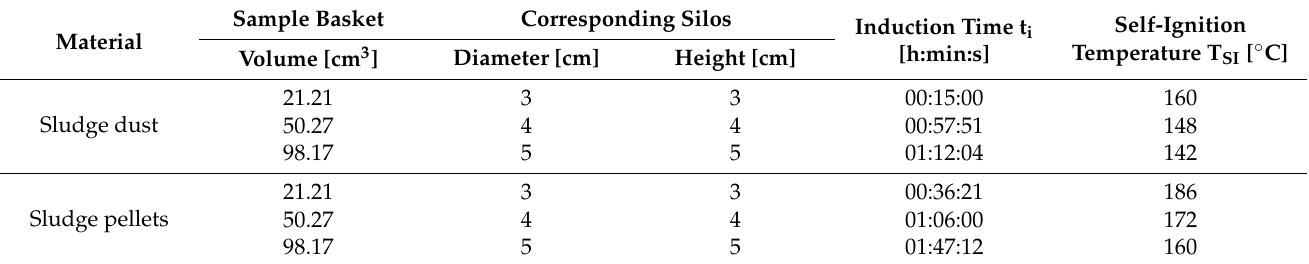
Table 8. The spontaneous ignition behavior analysis results.